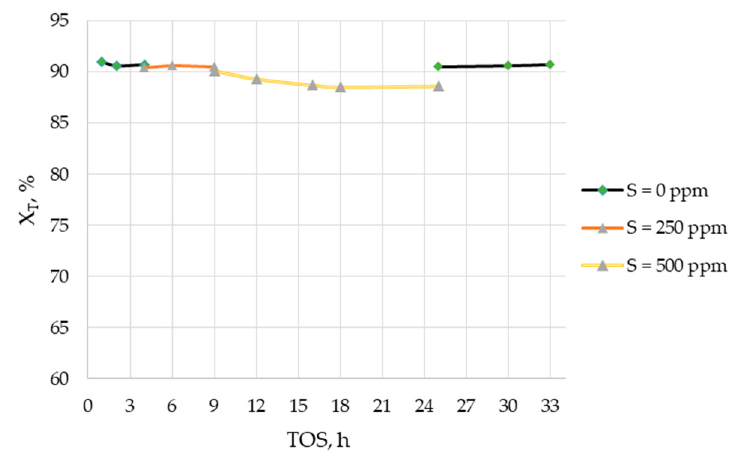
Figure 6. Sulfur tolerance of Ni-CrA-LiHPA catalyst for toluene hydrodealkylation: T = 753K, P = 0.7 MPa, WHSV 1.5 h -1.